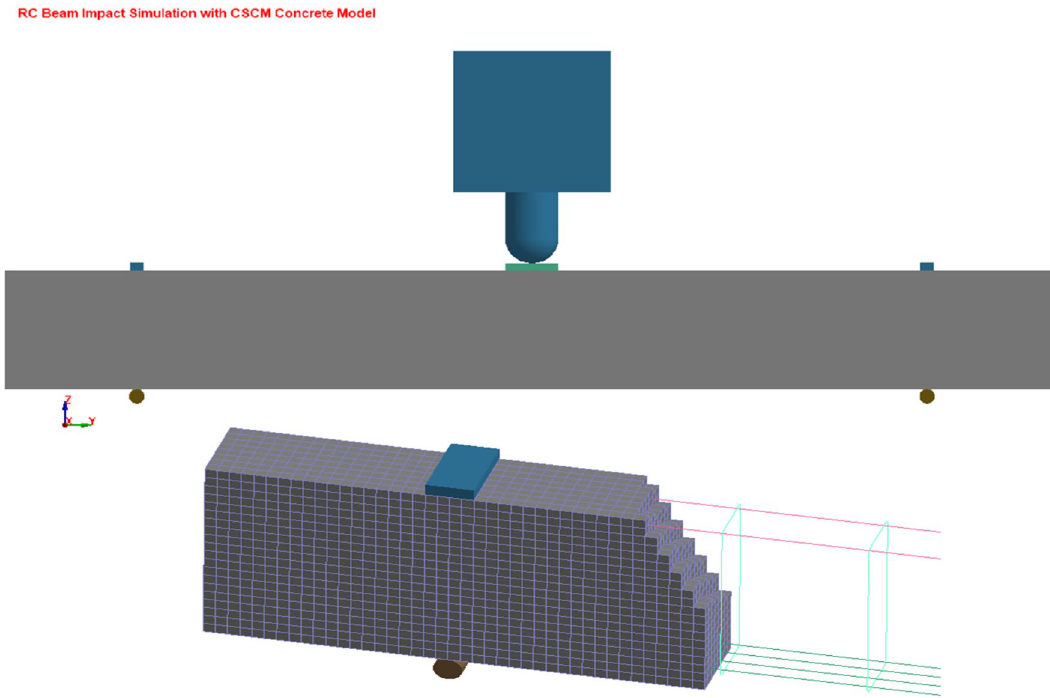
Fig. 3 LS-DYNA Model